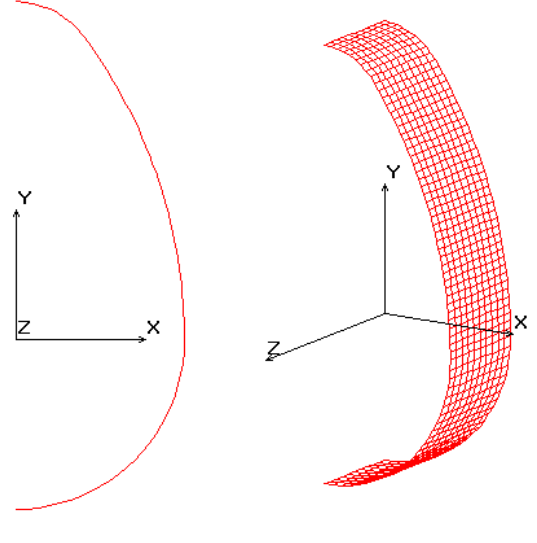
Figure 2: Calculation scheme of the finite element method.